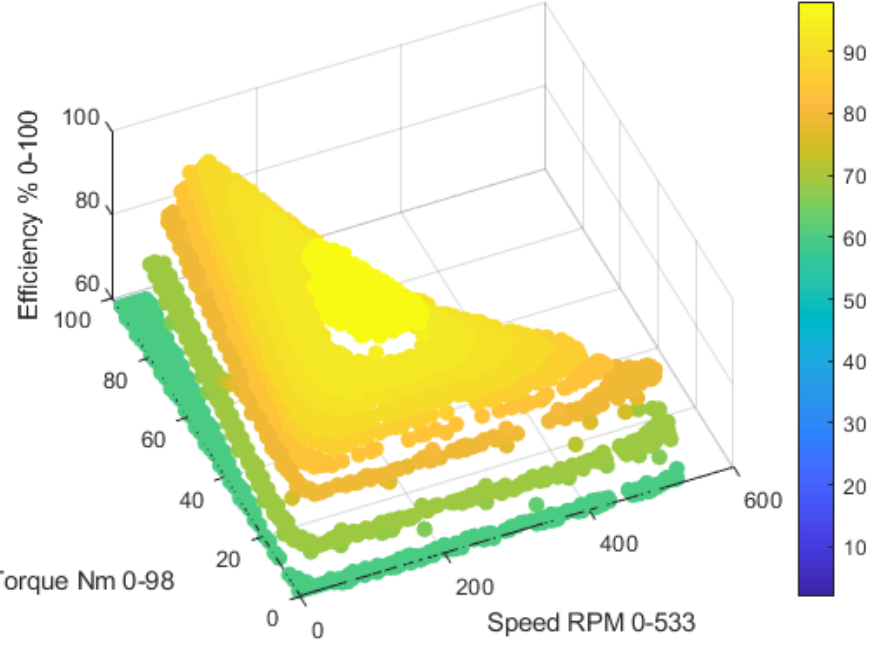
Figure 8. Efficiency map estimation result Ef f ( x 2 , T )